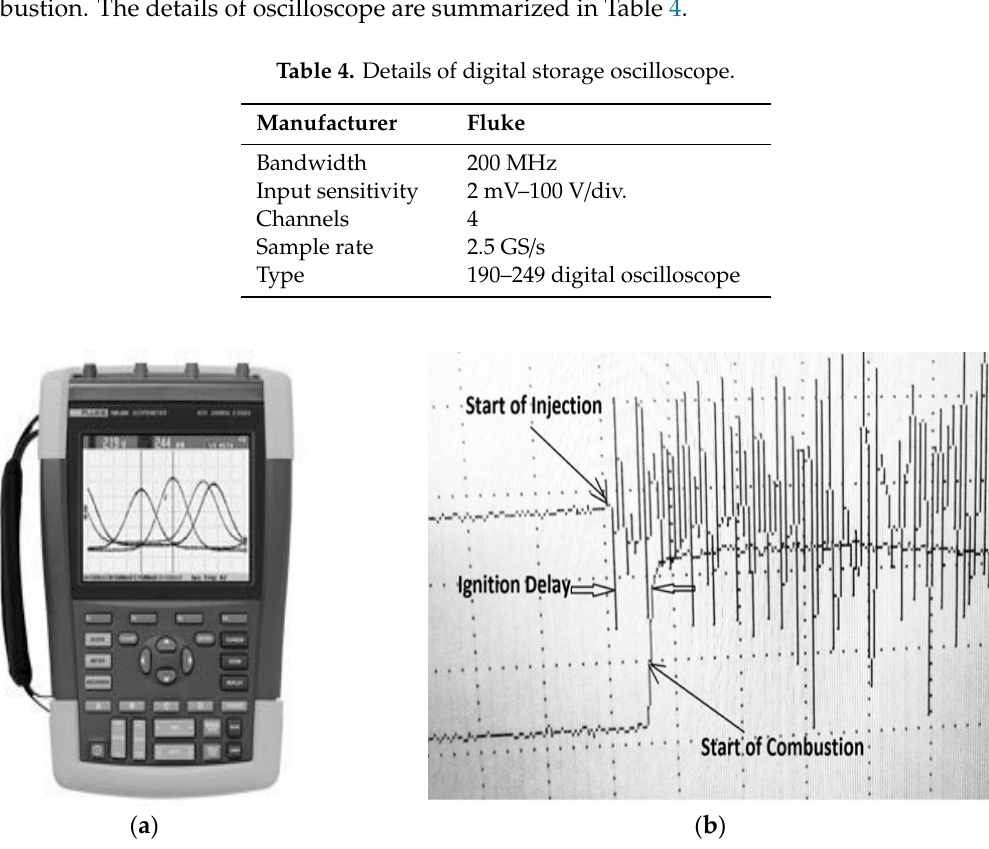
Table 5. Properties of diesel and diesel with fuel additive.